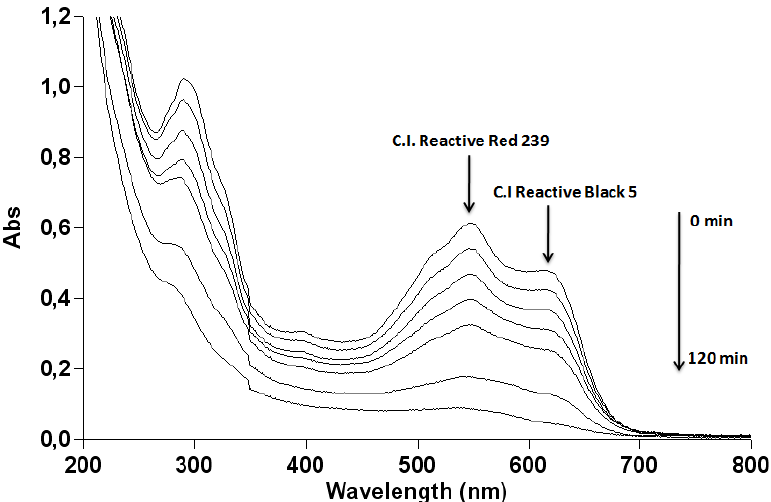
Figure 10. Photocatalytic degradation under 125 W mercury-vapor lamp irradiation with followed by UV-Vis spectrophotometry from 200 to 900 nm for a 0.1 g·L − 1 of TiO 2 30 mg·L − 1 mixture of C.I Reactive Black 5 and C.I Reactive Red